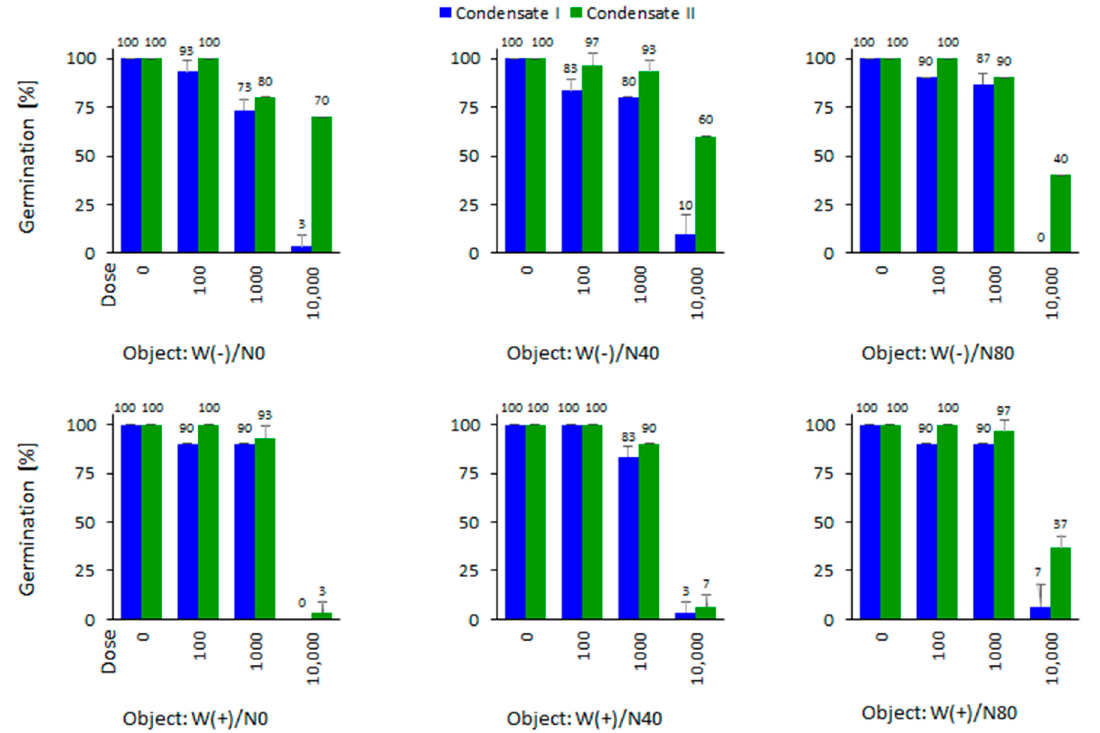
Figure 10. E ff ect of tar on Sinapis alba seed germination in ecotoxicity Figure 10. Effect of tar on Sinapis alba seed germination in ecotoxicity biotest.